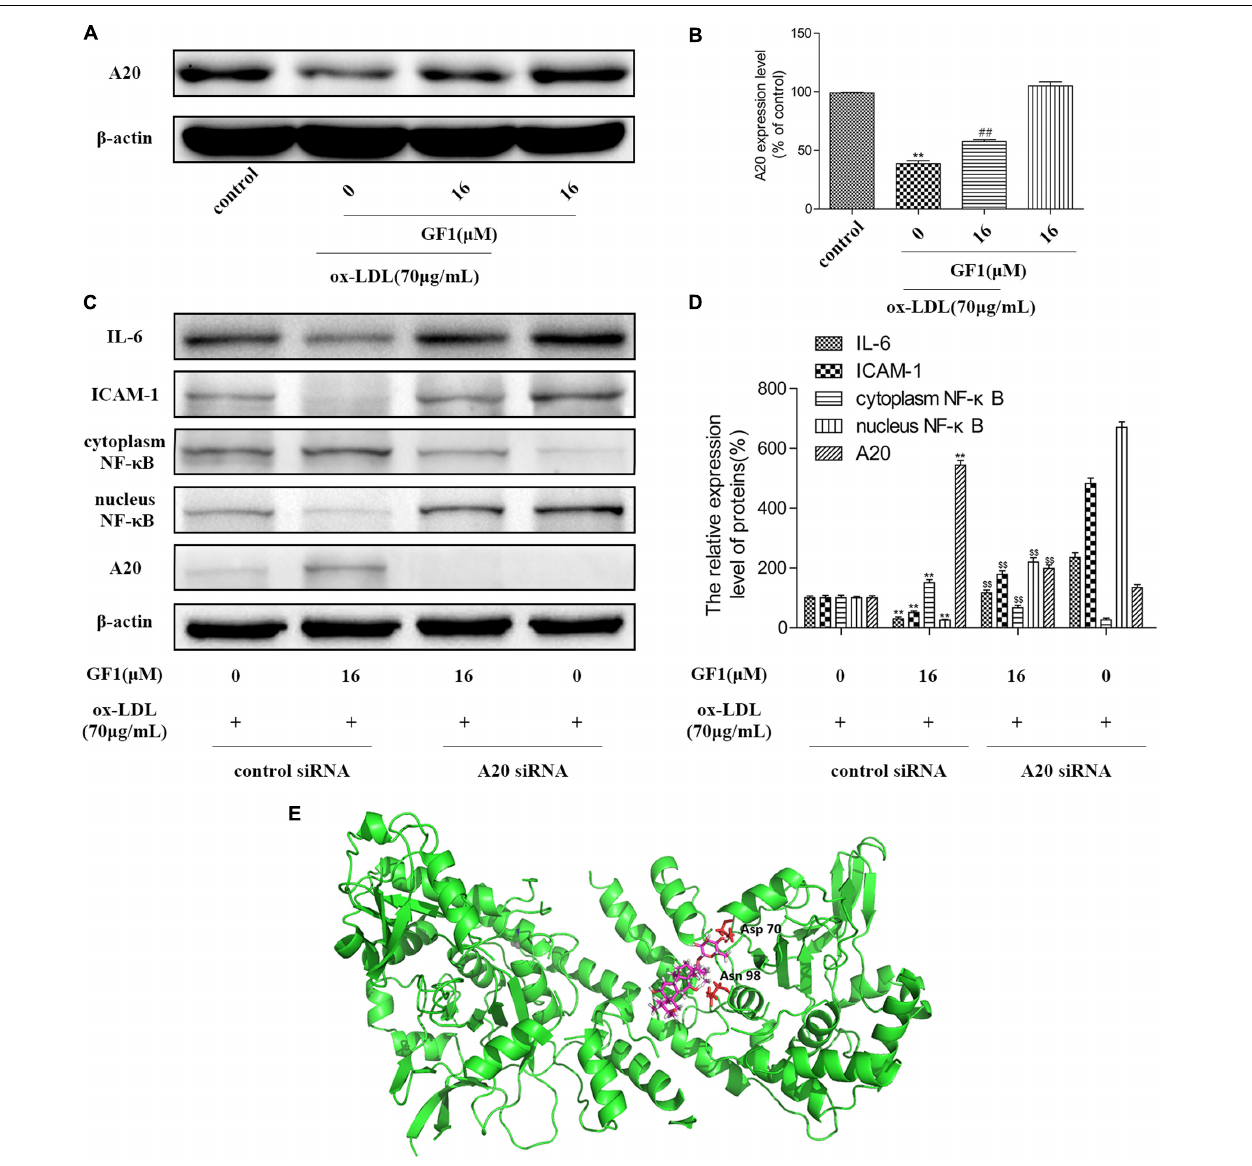
FIGURE 7 | Ginsenoside F1 inhibited NF- κ B signaling via A20 promotion. (A) HUVECs were pre-treated with various concentrations of GF1, followed by treatment with ox-LDL for another 24 h. Protein expression levels of A20 and β -actin were measured via western blotting. (B) Densitometric analysis was used to quantify the levels of A20. (C) A20 was knocked down by siRNA, as described in Materials and Methods. At 24 h post-transfection, cells were incubated with GF1 (16 µ M) for 12 h and then exposed to ox-LDL for another 24 h. Protein expression levels of A20, IL-6, ICAM-1, cytoplasm NF- κ B, nucleus NF- κ B and β -actin were measured via western blotting. (D) Densitometric analysis was used to quantify the levels of A20, IL-6, ICAM-1, cytoplasm NF- κ B, and nucleus NF- κ B. (E) Docking simulation of GF1 into A20. All of the results are expressed as the mean ± SD of three independent experiments. ## p < 0.01, vs. control group; ∗ p < 0.05, ∗∗ p < 0.01 vs. ox-LDL group; p $$ < 0.01 vs. ox-LDL+GF1